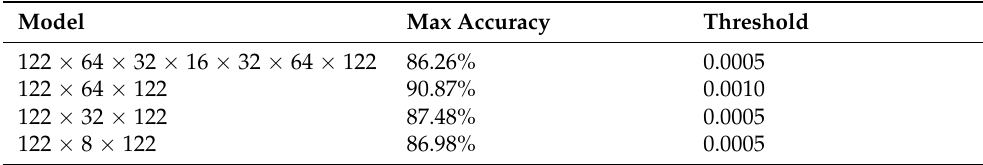
Table 5. Comparison of ADA configurations with the NSL-KDD dataset.